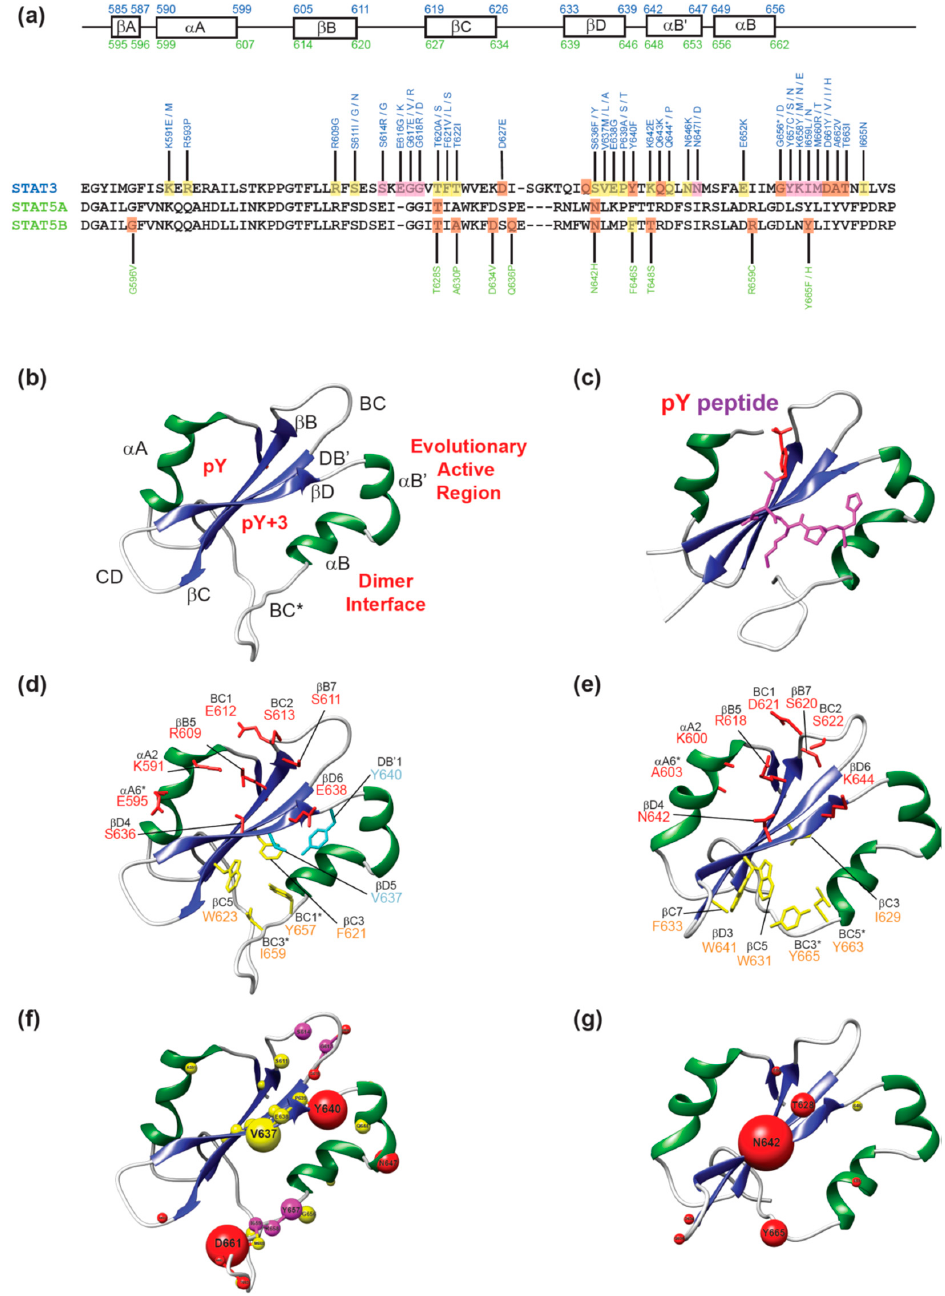
Figure 1. ( a ) Secondary structural motifs in STAT3 (blue) and STAT5 (green) with mutations annotated; ( b ) Structure of STAT3 SH2 domain; ( c ) Structure of pY-peptide-STAT1 SH2 domain. The pY residue is depicted in red with the C-terminal residues in violet; ( d ) Structure of STAT3 SH2 domain with Sheinerman residues (red), hydrophobic system residues (yellow) and the selectivity filter (cyan); ( e ) Structure of STAT5B SH2 domain with the same color scheme as above; ( f ) STAT3 SH2 domain with all mutations highlighted in spheres. The volume of each sphere is proportional to frequency of cases identified. Red spheres indicate an activating mutation, yellow spheres indicate a destabilizing mutation and magenta spheres represent sites where both activating and refractory